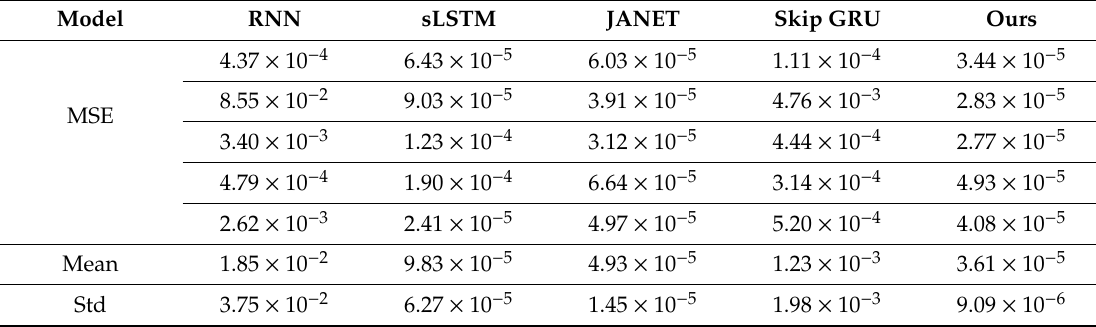
Table 1. The experimental results of the adding task.